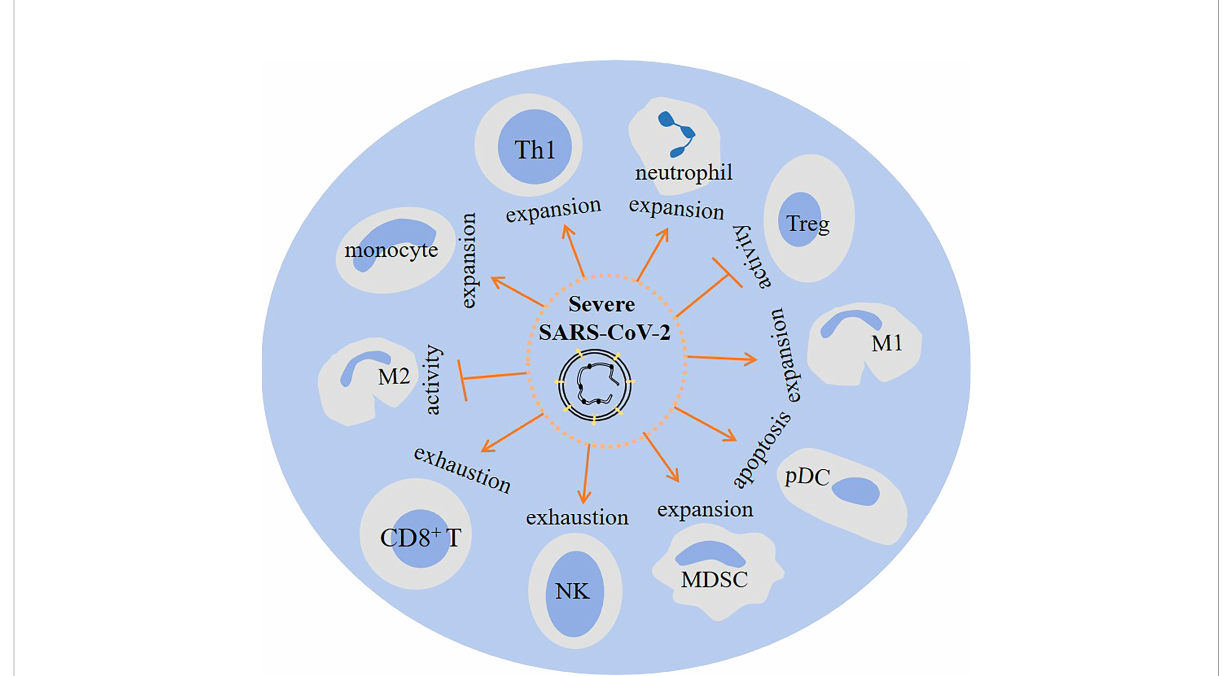
FIGURE 5 The impact of severe SARS-Cov2 induced disease on cellular immunity. In patients with a severe disease the activity of regulatory T cell (Tregs) and M2 macrophage is hampered. Whereas M1 macrophage, myeloid-derived suppressor cells (MDSCs), monocytes, neutrophils and Th1 cells show increased expansion. Other consequences of a severe infection are plasmacytoid dendritic cell (pDC) apoptosis, and CD8+ T cell and natural killer (NK) cell